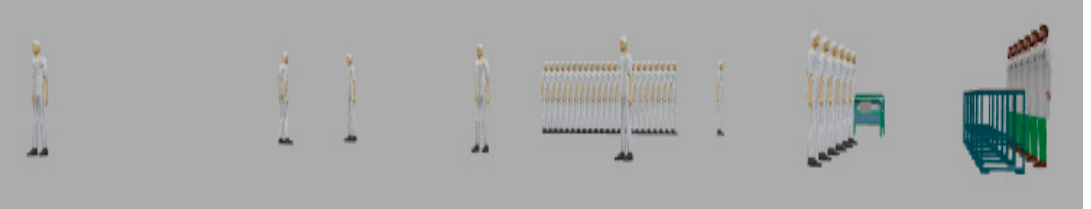
Figure 37. AnyLogic Patient-Doctor Simulation 3D Model in Execution (side viewpoint).